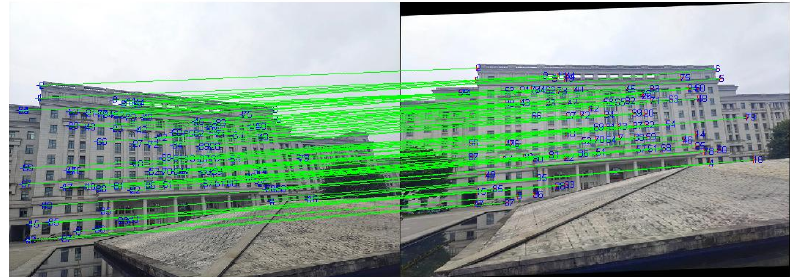
Figure 9. The fine matching results for the 0°and 15° images of the first scene. In Figure 9, there are 85 matched point pairs, and the obtained projection transform matrix M ab is specified by Equation (4). According to this transform matrix, the 0°and 15° images are registered and stitched together. The final stitched result is shown in Figure 10.